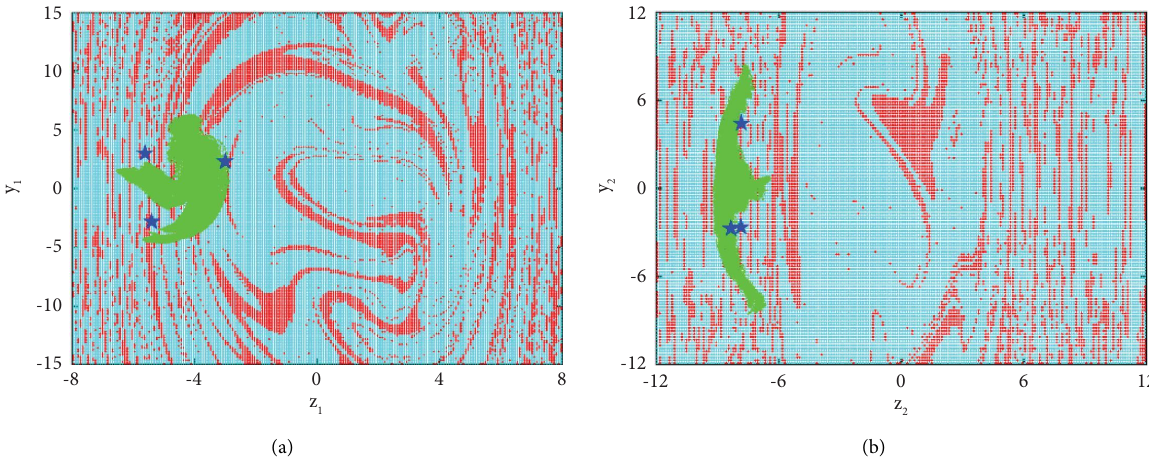
Figure 6: Te attractors and their basins of attraction during system response. (a) Te z